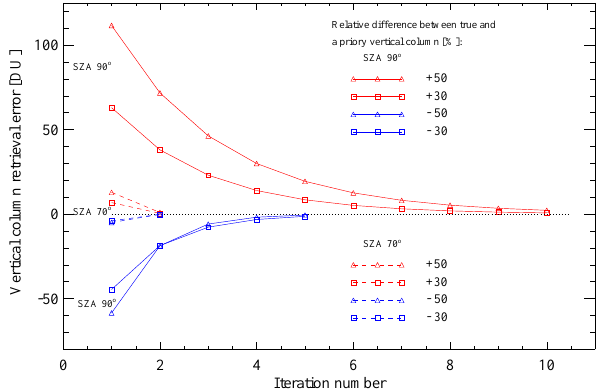
Fig. 6. Root mean square of the linearization error for WFDOAS (red line) and MDOAS (black line) equations at a solar zenith angle of 90 ◦ for a priori ozone vertical column of 350DU.